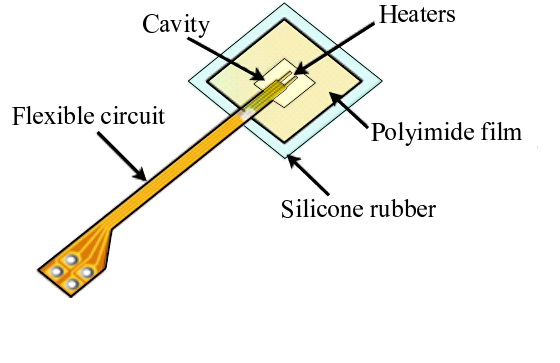
Fig. 1 Perspective view of HF sensor.